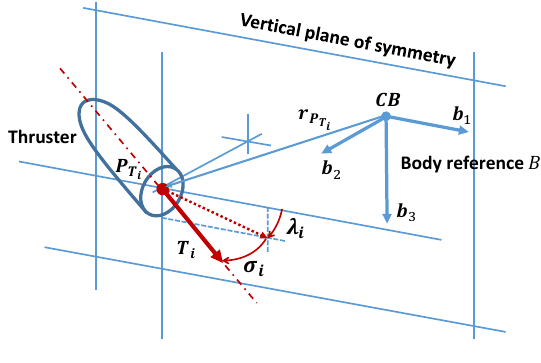
Figure 2. Definition of thruster position and orientation angles with respect to body reference. Swing angle σ i and tilt angle λ i are positive as shown with respect to reference B